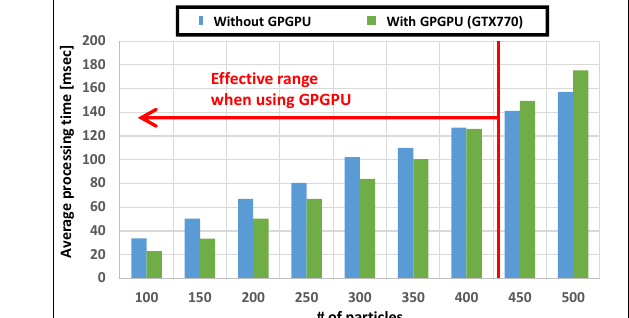
Figure 5. Processing time with and without GPGPU